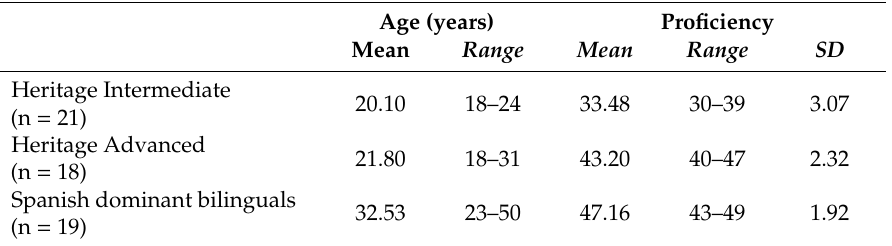
Table 1. Participant